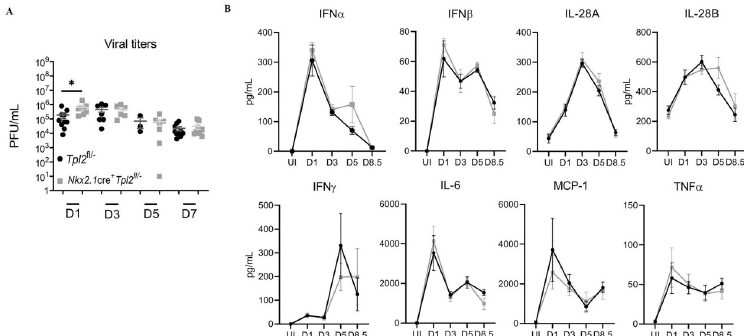
Fig 3. Nkx2 . 1 cre + Tpl2 fl/- mice have impaired early viral control but normal inflammatory cytokine profiles. (A) Lung viral titers determined by plaque assay in mice infected with 10 4 pfu influenza A/x31 for the indicated times. Pooled data from 4 separate experiments, 1 experiment per time point. Mice per group- D1: Tpl2 fl/- , N = 10. Nkx2 . 1 cre + Tpl2 fl/- , N = 8; D3: Tpl2 fl/- , N = 7. Nkx2 . 1 cre + Tpl2 fl/- , N = 6; D5: Tpl2 fl/- , N = 3, Nkx2 . 1 cre + Tpl2 fl/- , N = 7; D7: Tpl2 fl/- , N = 10, Nkx2 . 1 cre + Tpl2 fl/- , N = 9. (B) Cytokine expression in mice treated as in A was determined by Procartaplex immunoassay; data representative of 2 experiments. Mice per group—UI Tpl2 fl/- , N = 4, Nkx2 . 1 cre + Tpl2 fl/- , N = 4; D1: Tpl2 fl/- , N = 3, Nkx2 . 1 cre + Tpl2 fl/- , N = 3; D3: Tpl2 fl/- , N = 6, Nkx2 . 1 cre + Tpl2 fl/- , N = 6; D5 Tpl2 fl/- , N = 3, Nkx2 . 1 cre + Tpl2 fl/- , N = 3; D8.5: Tpl2 fl/- , N = 4, Nkx2 . 1 cre + Tpl2 fl/- , N = 5; Error bars represent means ± SEM. � p < 0.05, �� p < 0.01, ��� p < 0.001, ���� p < 0.0001; one-way ANOVA unless otherwise noted.